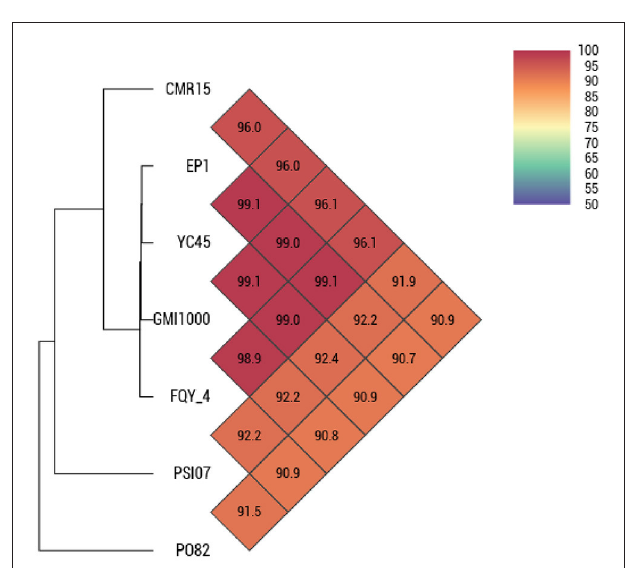
amount of inversions distributed across the genome ( Figure 4C ).